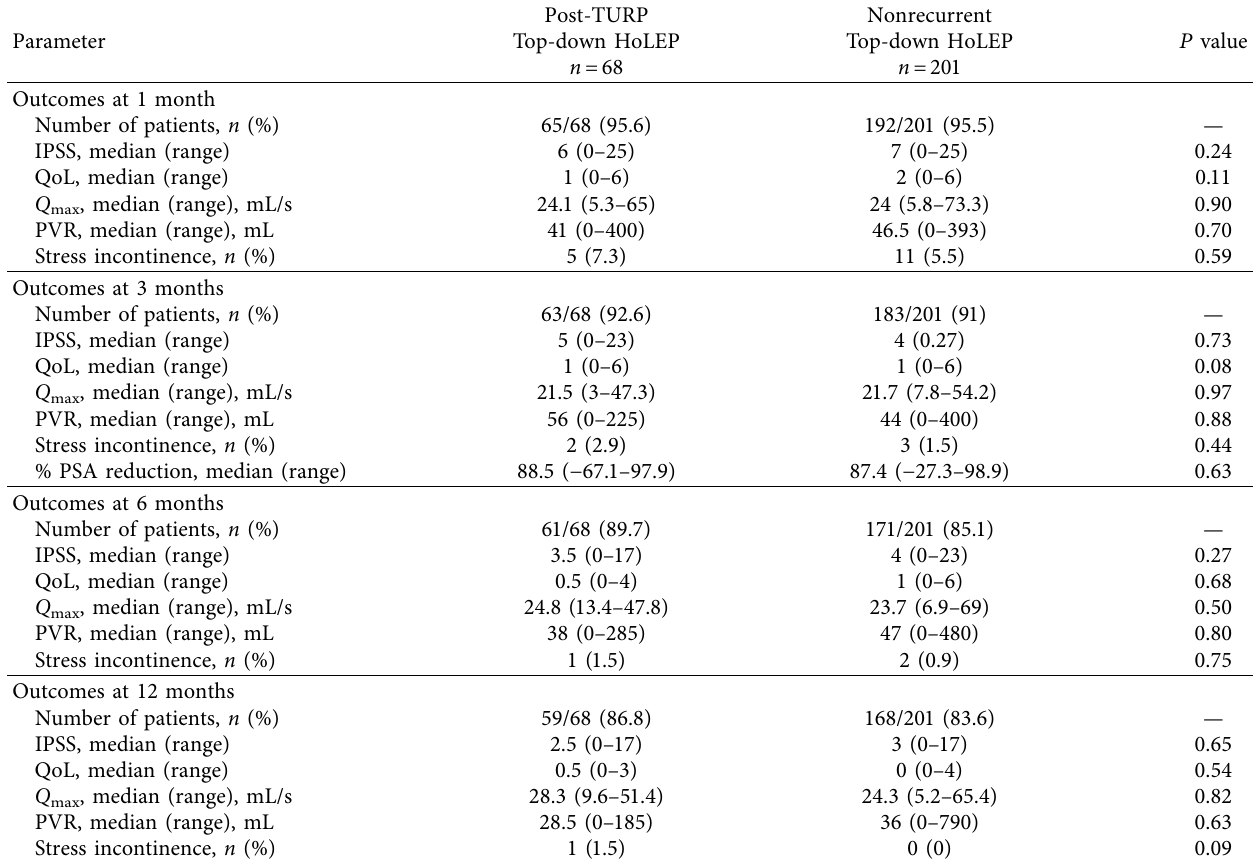
Table 3: Outcomes at 1, 3, 6, and 12 months follow-up.